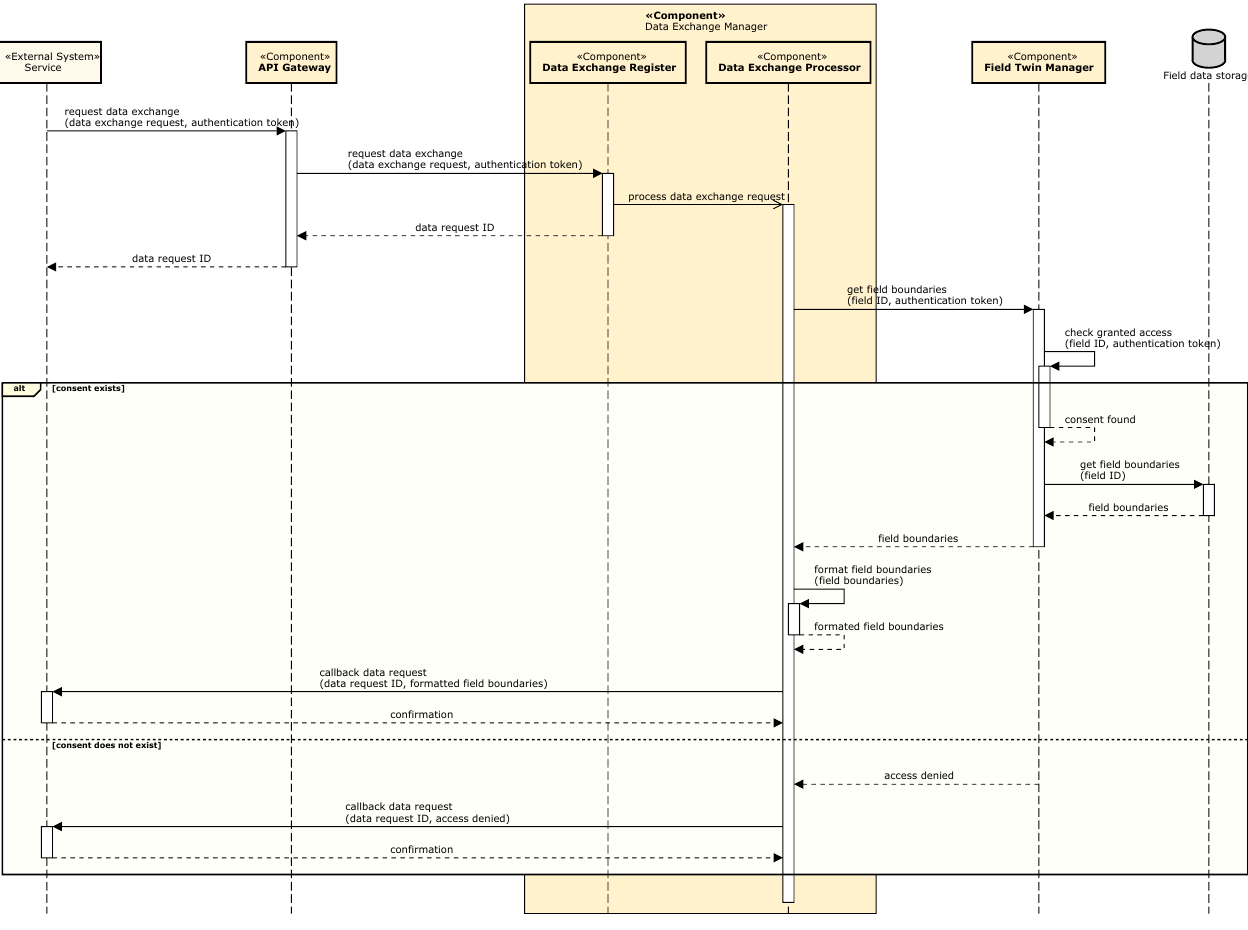
Figure 11. Example of the data exchange strategy for a READ operation. First, a service requests the reading of the field boundaries of a certain field. Next, the request reaches the Twin-Hub through its API and is forwarded to the Data Exchange Manager, which stores the data request. Then the Data Exchange Manager asks the Field Twin Manager for the data, which in turn retrieves the data from the storage. Finally, the Data Exchange Manager formats the field data and calls the requester back with a request to send the requested